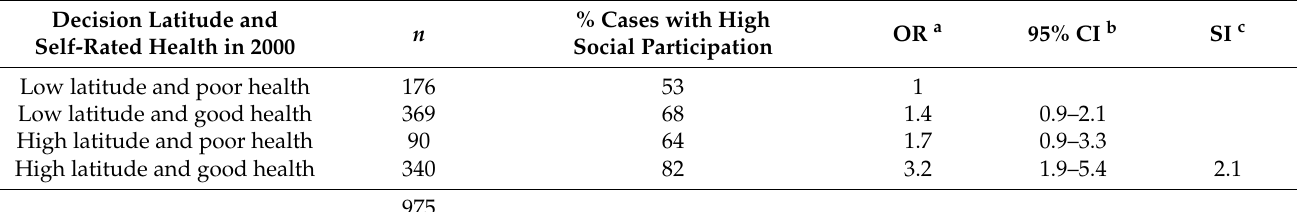
Table 5. Interaction analysis with synergy index, regarding latitude at work and self-rated health, both measured at baseline in 1999 and social participation in 2010. Scania Public Health Cohort, n = 975.